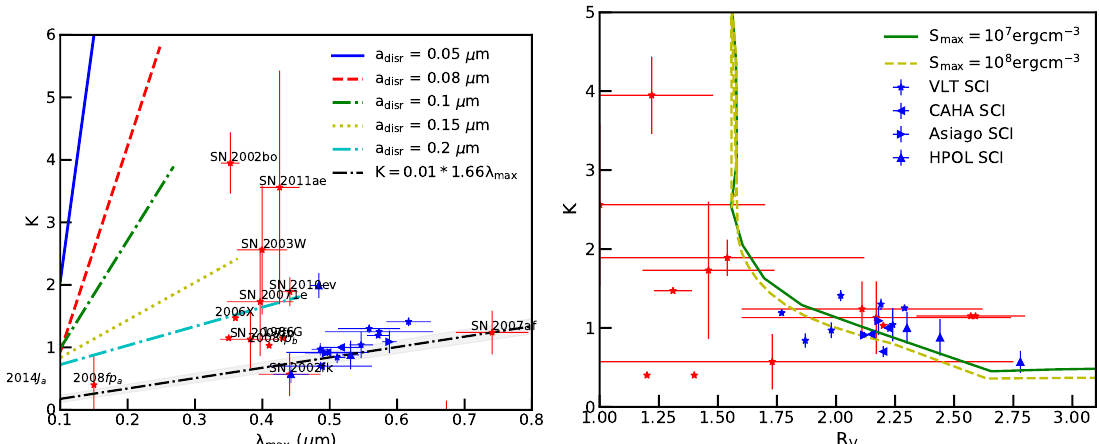
Figure 21. Left panel: Relationship between K and λ max predicted by our model for different disruption λ max relationship. Right panel: K vs. R V sizes and alignment size. The black line is the standard K − from our models compared with observational data for SNe Ia. Symbols show observational data for SNe Ia presented (red symbols) and normal stars in our galaxy (blue symbols). From Giang et al.